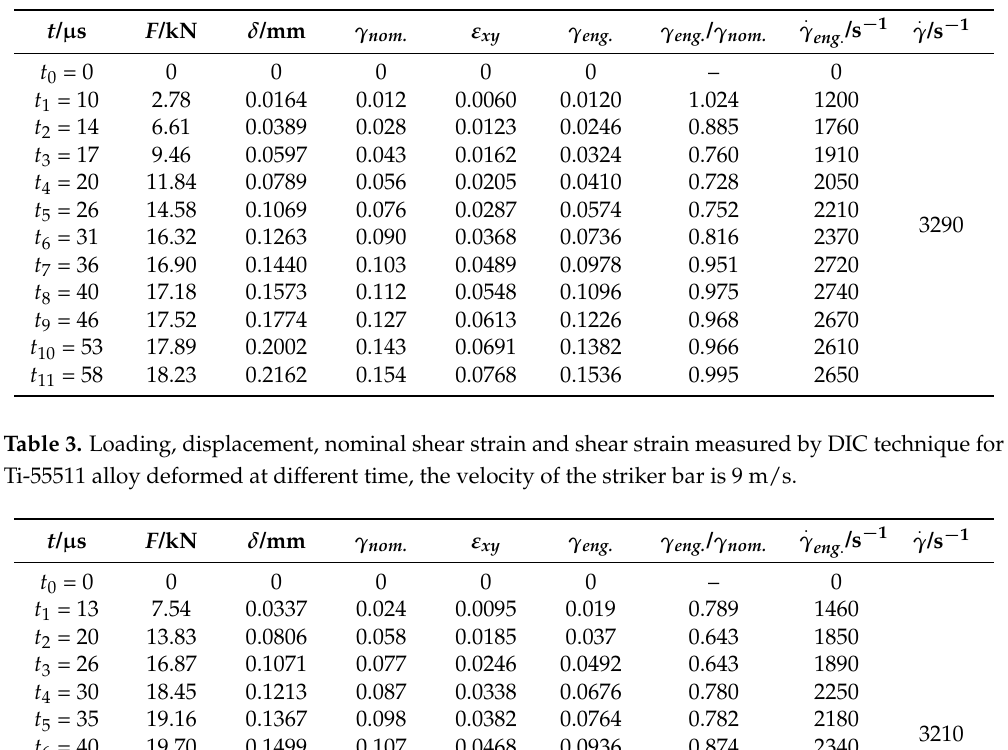
Table 2. Loading, displacement, nominal shear strain and shear strain measured by DIC technique for Ti-64 alloy deformed at different time, the velocity of the striker bar is 9.2 m/s.